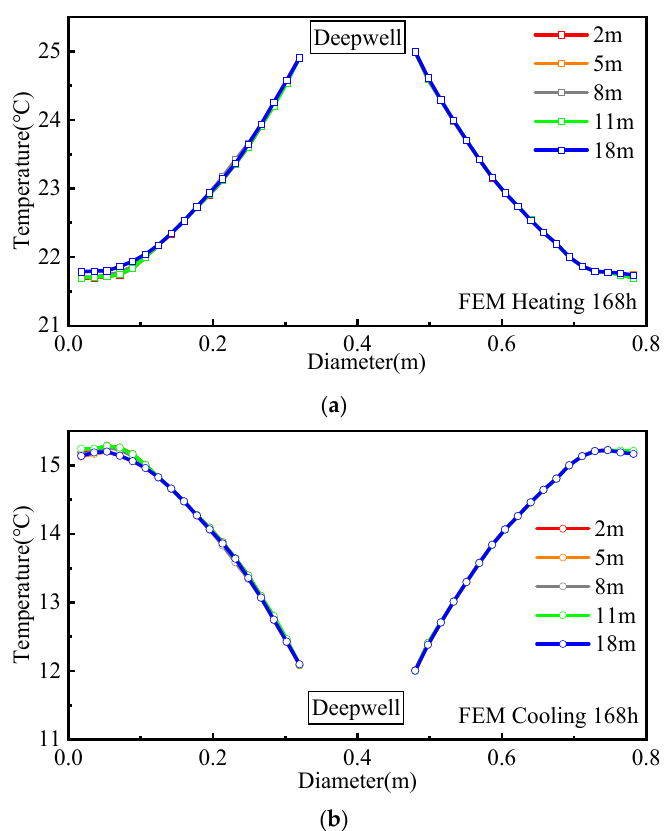
Figure 8. Temperature distribution in the radial direction at each depth of the pile: ( a ) heating condition; ( b ) cooling condition.